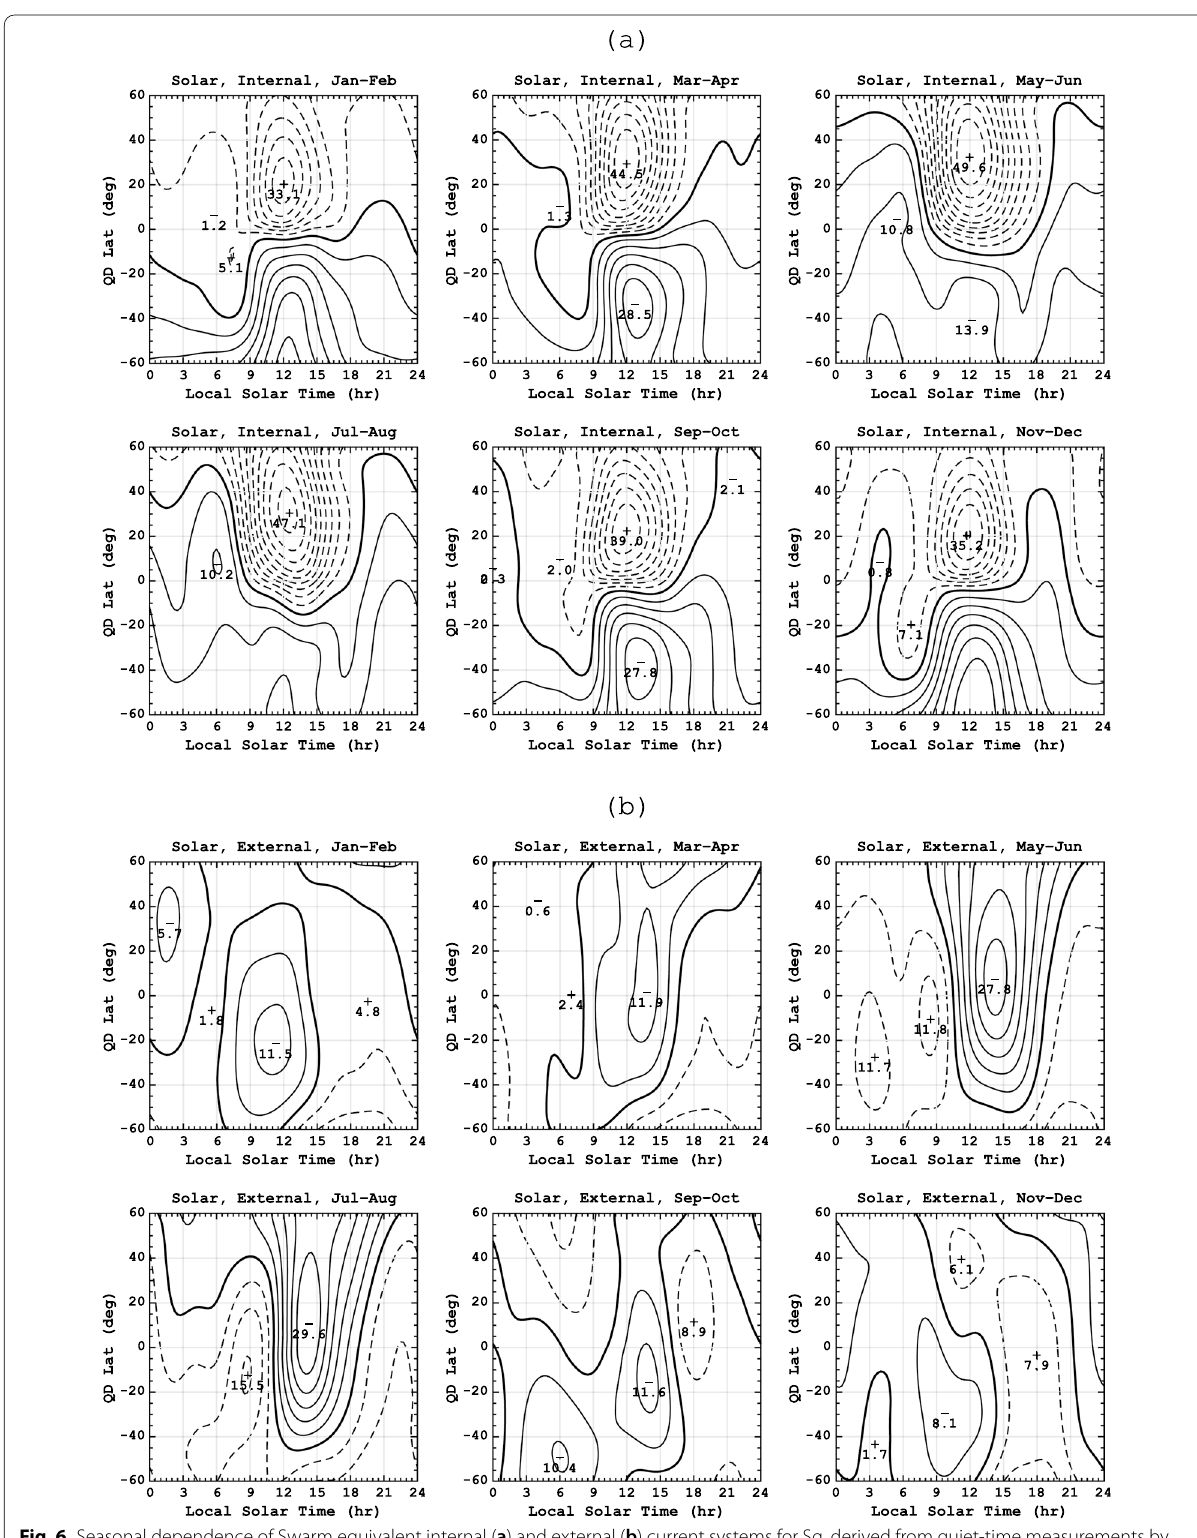
Fig. 6 Seasonal dependence of Swarm equivalent internal ( a ) and external ( b ) current systems for Sq, derived from quiet-time measurements by Swarm A and B during 2017–2020. Contour steps are 5 kA for both a and